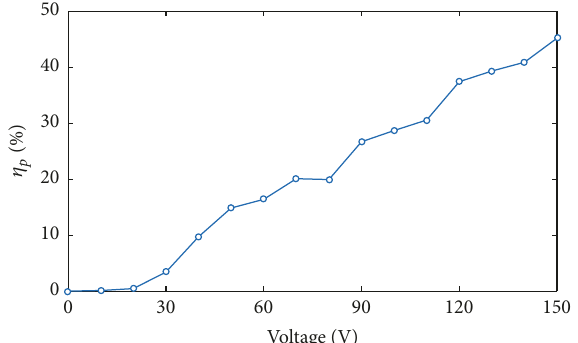
Figure 13: The peak vibration-reduction ratio 𝜂 𝑝 as a function of the control voltage.